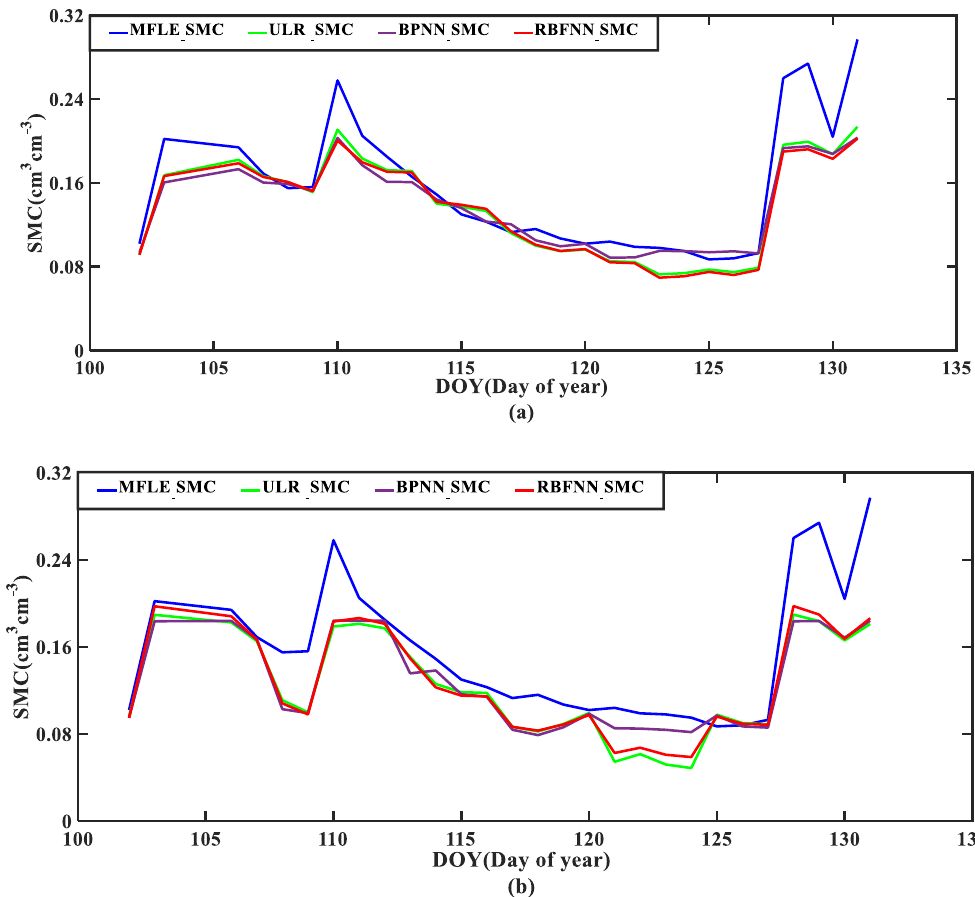
Figure 16. For P041 station; comparison between the predicted values of three models and measured